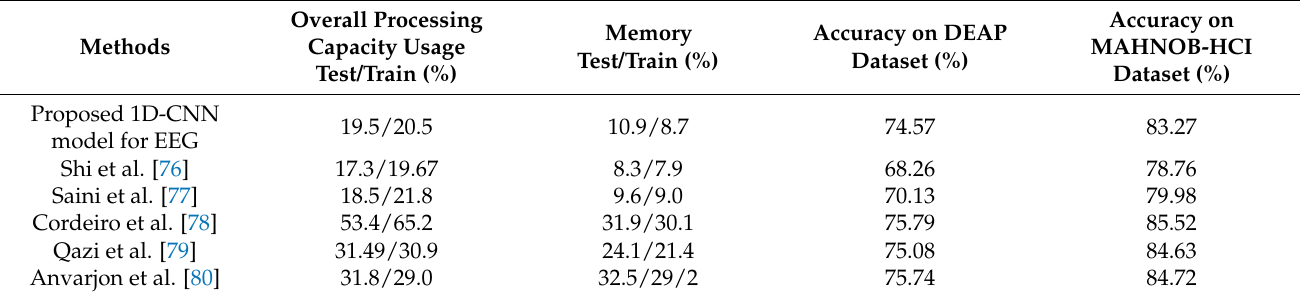
Table 13. Comparison of hardware resource utilization of the proposed 1D-CNN model for EEG signals and other lightweight methods.